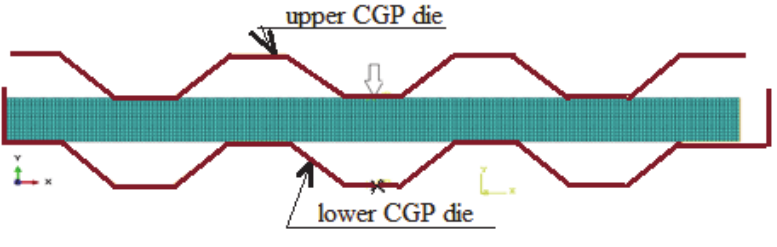
Figure 3: Finite element discretization of